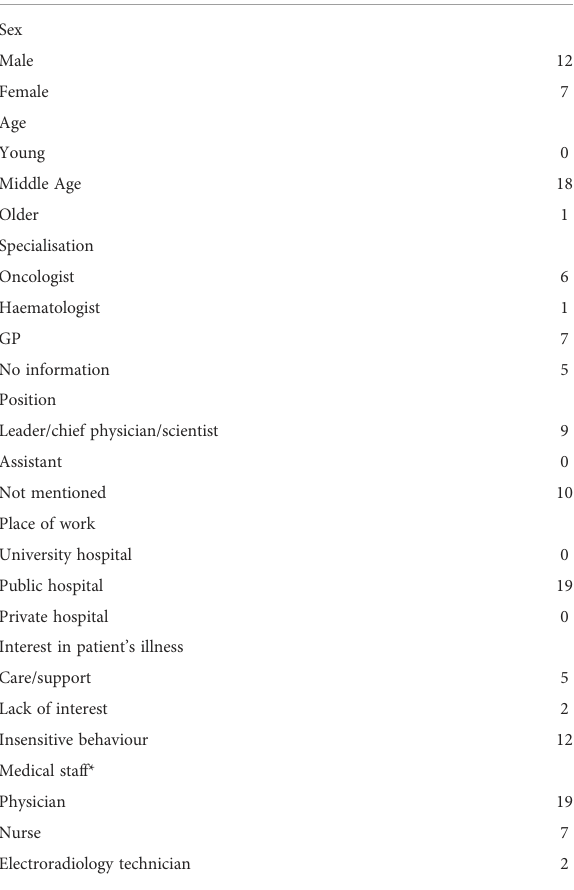
TABLE 5 Cinematic images of